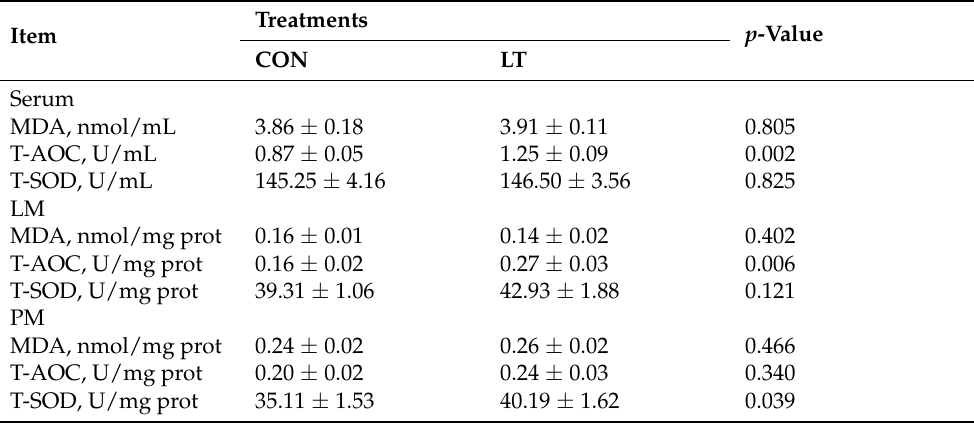
Table 6. Effects of low-temperature on antioxidant capacity in serum and skeletal